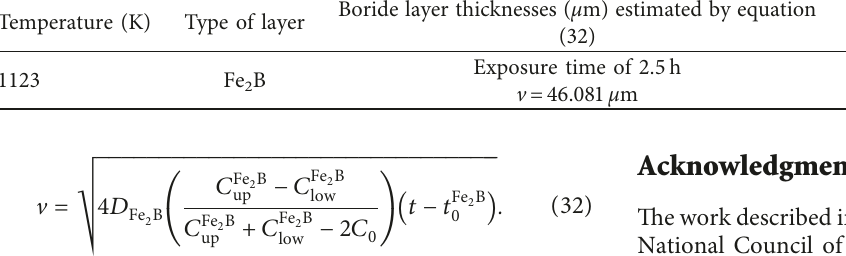
Table 4: Estimated value of ASTM A36 boride layer thickness ( v ) obtained at the 1123K of boriding temperature with an exposure time of 2.5h. Temperature (K) Type of